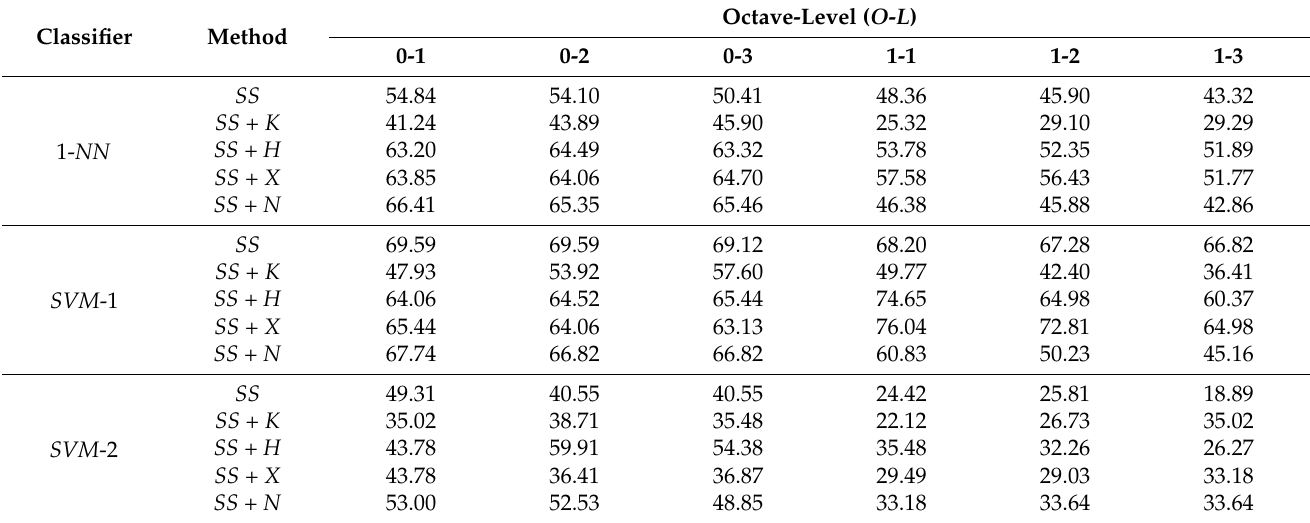
Table 4. The detailed accuracy (%) results of the scale-space method and its combination with a